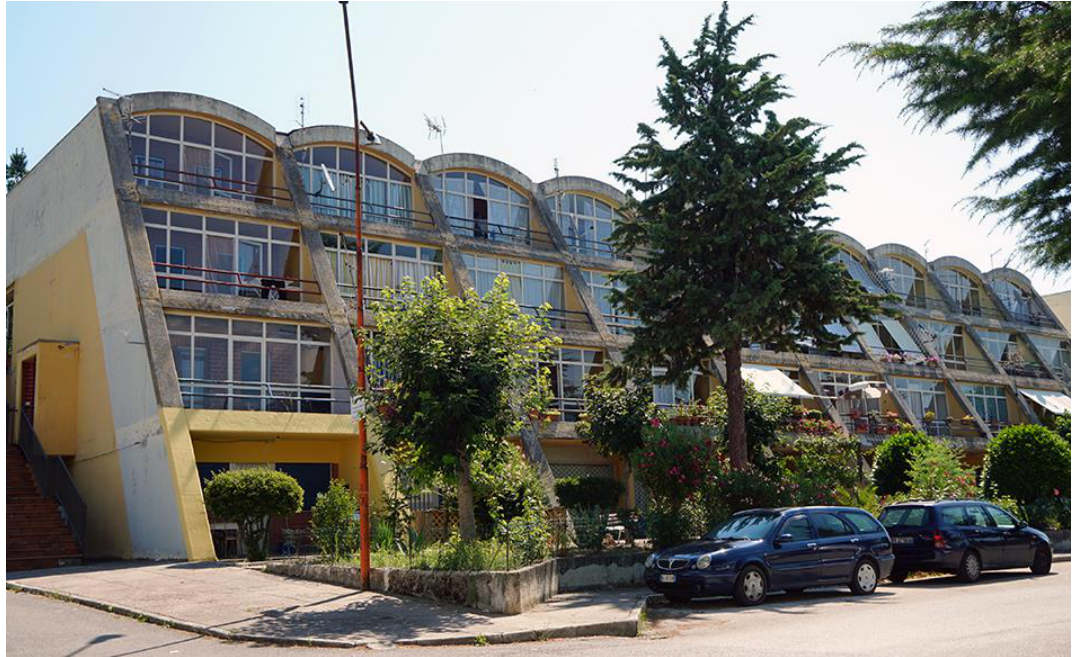
Figure 23. Lioni: one of the first buildings built in 1985, the “Bergamo condominium” is in reinforced concrete, built thanks to the solidarity of the inhabitants of Bergamo (Northern Italy) (photos by [35,36]).